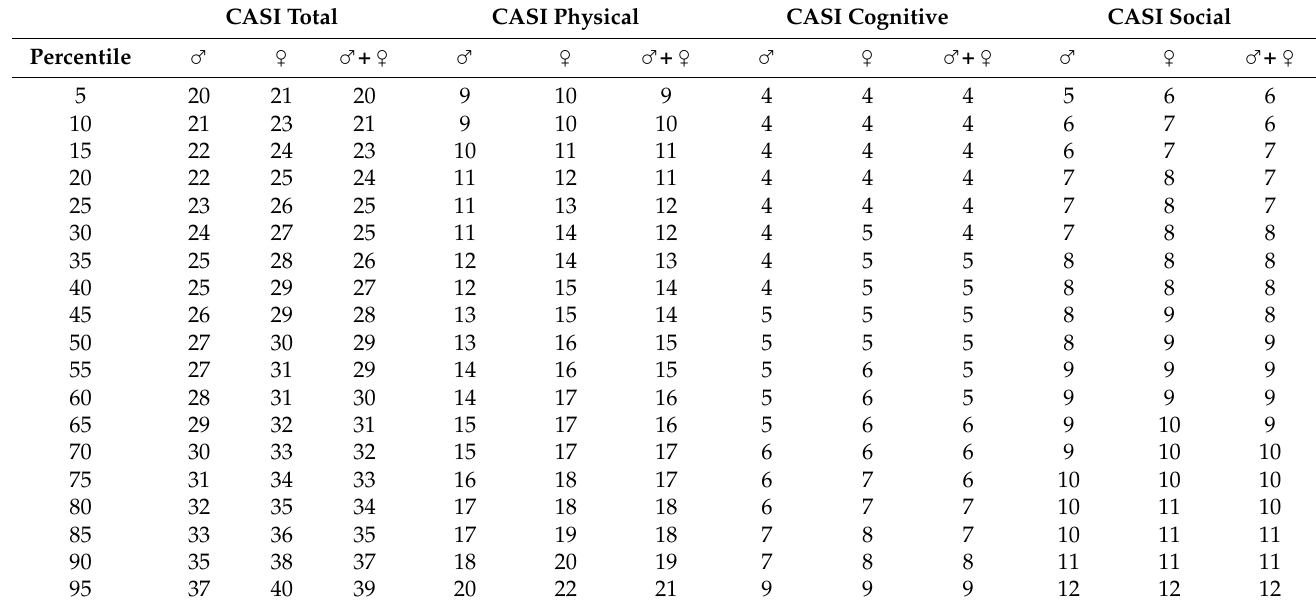
Table A2. Spanish version of the Childhood Anxiety Sensitivity Index (CASI) *.